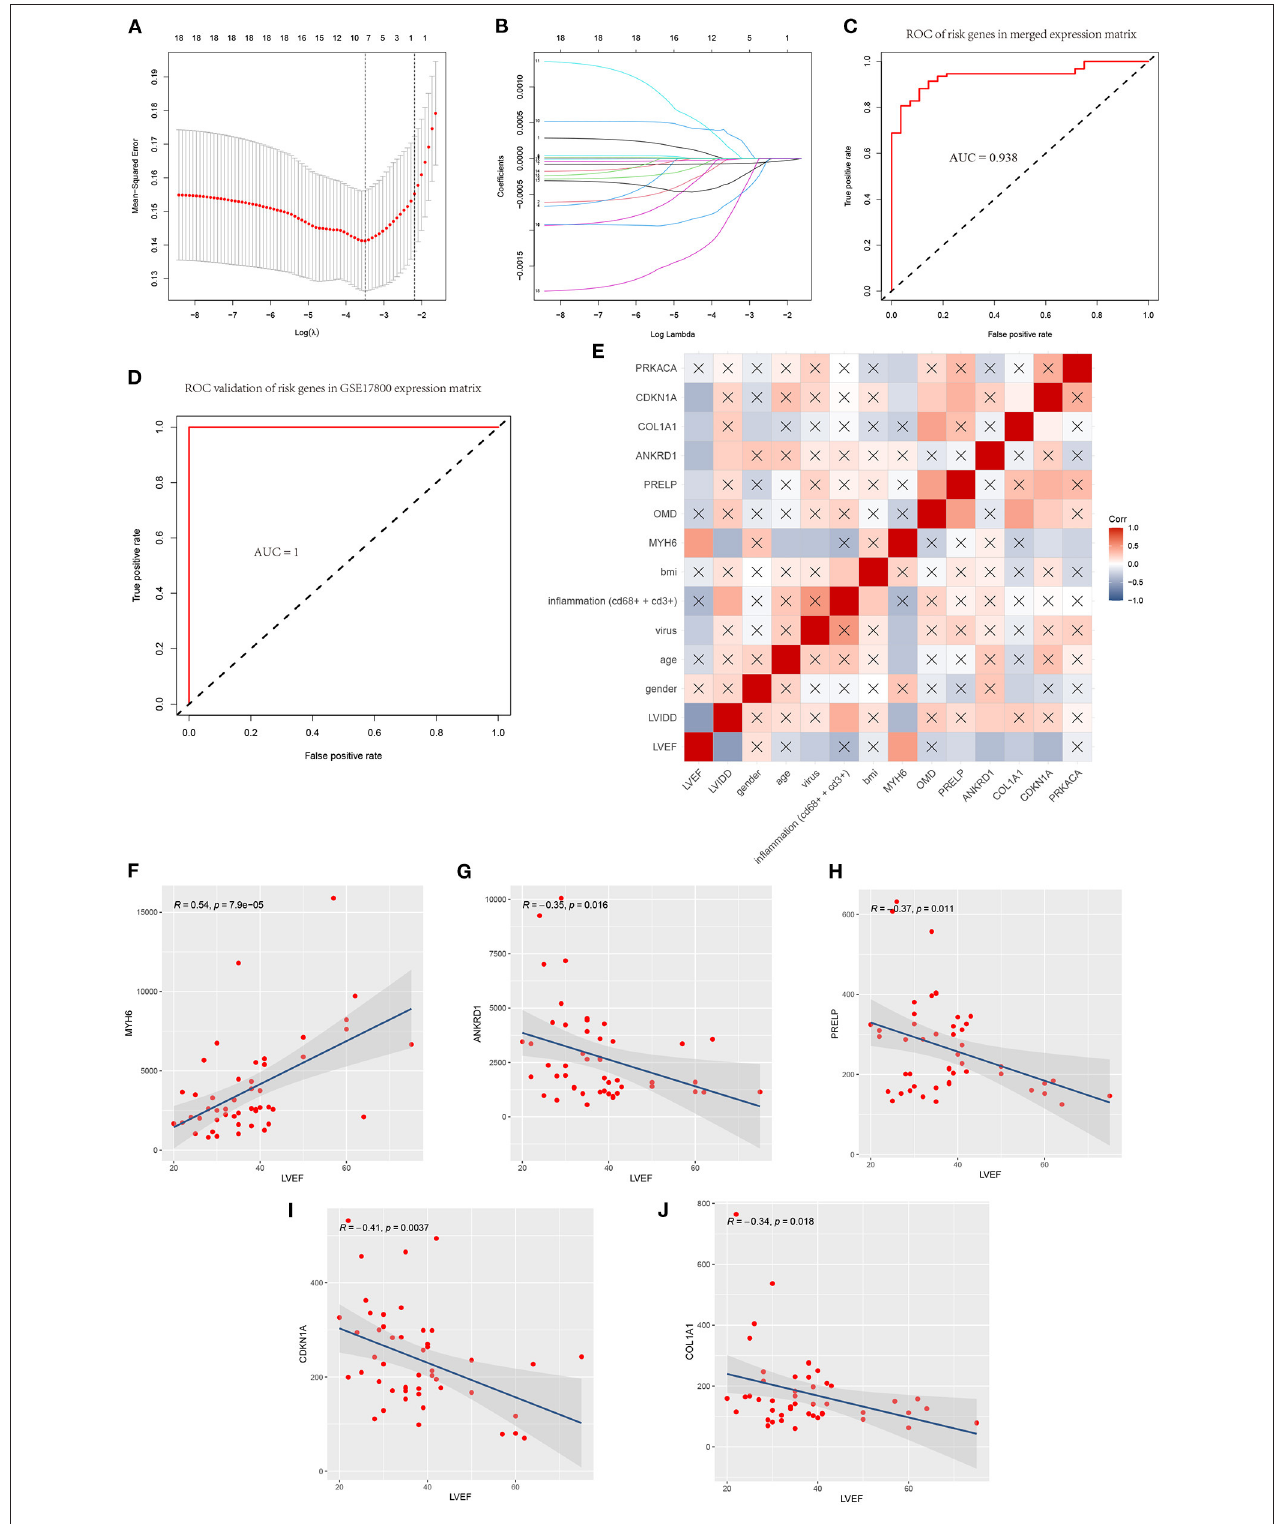
FIGURE 8 | A model for predicting DCM and correlation of clinicopathological features and model genes. (A) Least absolute shrinkage and selection operator (LASSO) logistic regression algorithm to screen diagnostic markers and risks genes in merged data matrix of five datasets. (B) Parameters of Lasso path